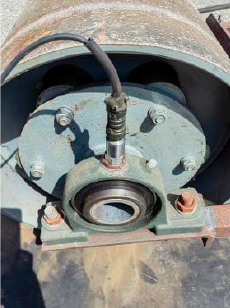
Figure 11. Field test of test prototype of “machine-pavement” vibratory system.